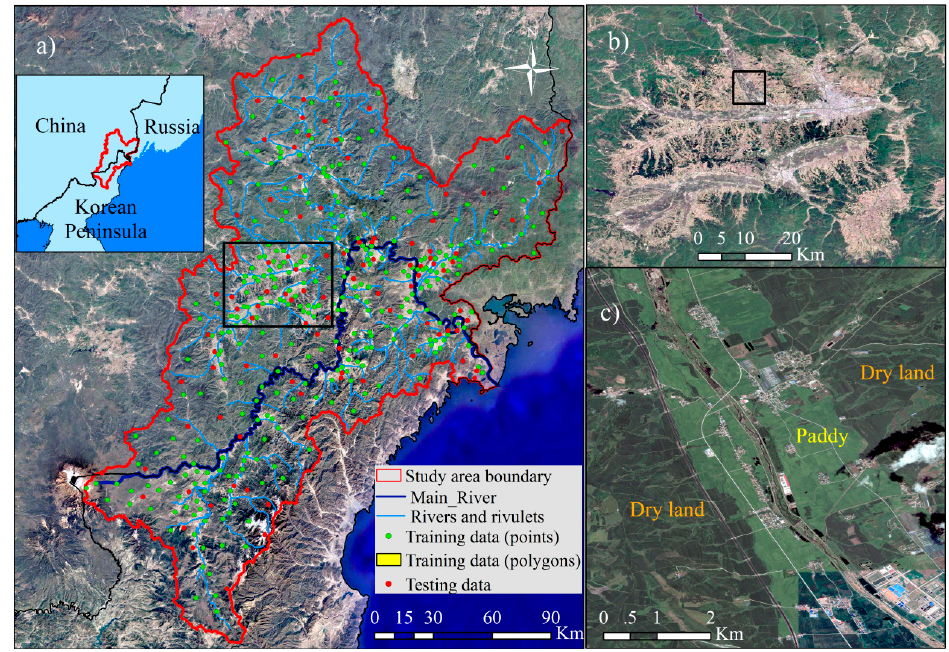
Figure 1. Location of study area and the distribution examples of reference data ( a ) for 2010 land cover classification and farmland status ( b , c ).